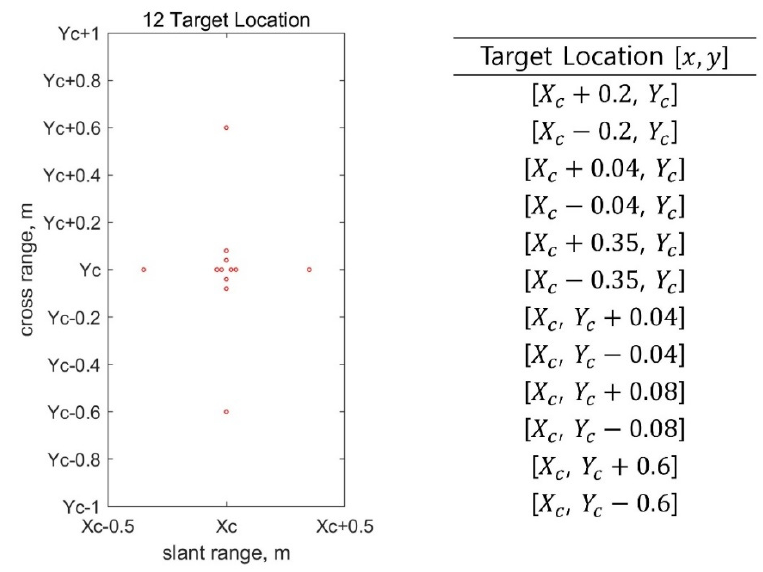
Figure 4. Locations of the 12 targets.